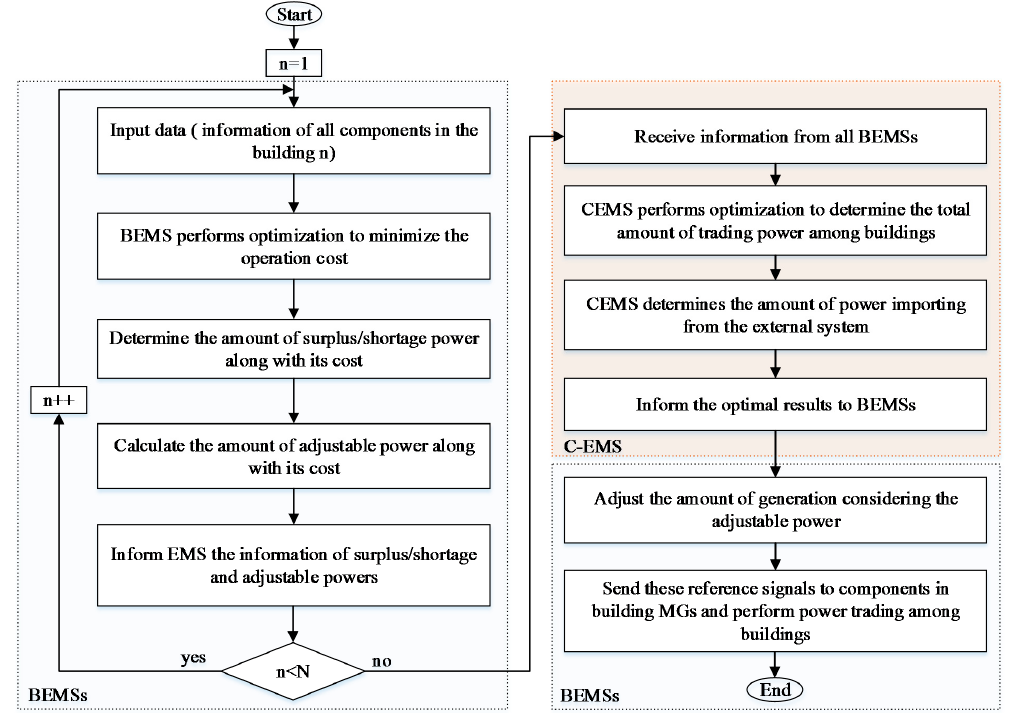
Figure 2. Operation strategy of the CCHP system in normal operation mode.